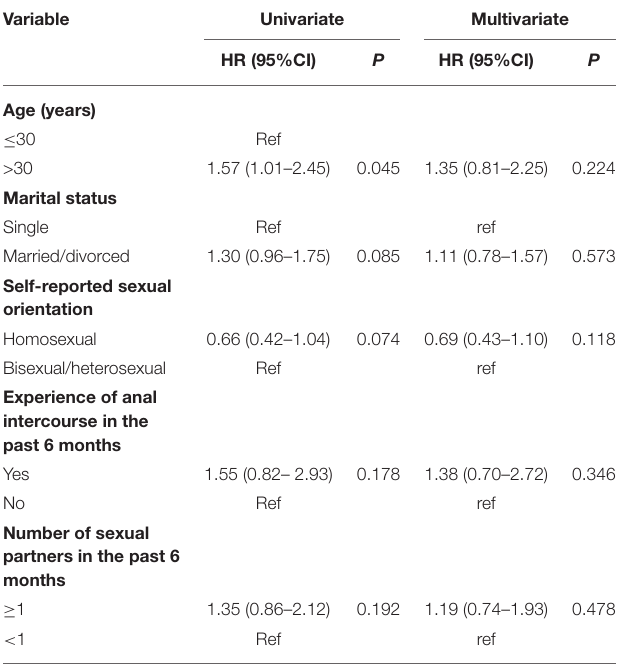
TABLE 3 | Factors associated reinfection of any nine-valent HPV types (9v-HPV) at baseline ( N =